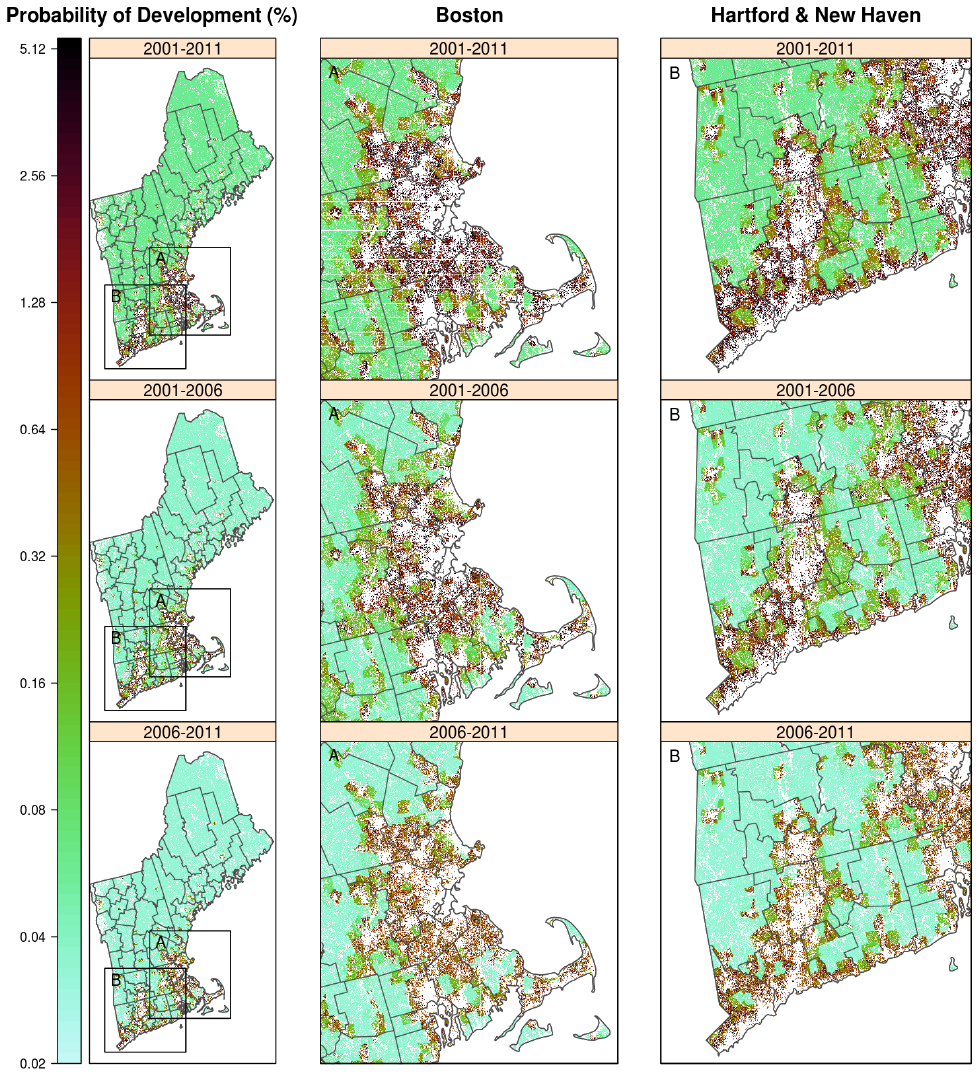
Figure 4. Probability of development surfaces for BRT models for 2001–2011 ( top ) and for the two sub-intervals, 2001–2006 ( middle ) and 2006–2011 ( bottom ). The second and third columns show closeups of the areas of highest development probability, the area around Boston (A) and the area around New Haven and Hartford (B). For each time interval, only pixels containing forest in 2011 are shown in color. Other land cover types are shown in white. The color scheme was generated using David Green’s “cubeHelix” implemented in the R package “rje” (Green 2011, Evans 2014). Non-forest land cover is shown in white, and county boundaries are shown in dark